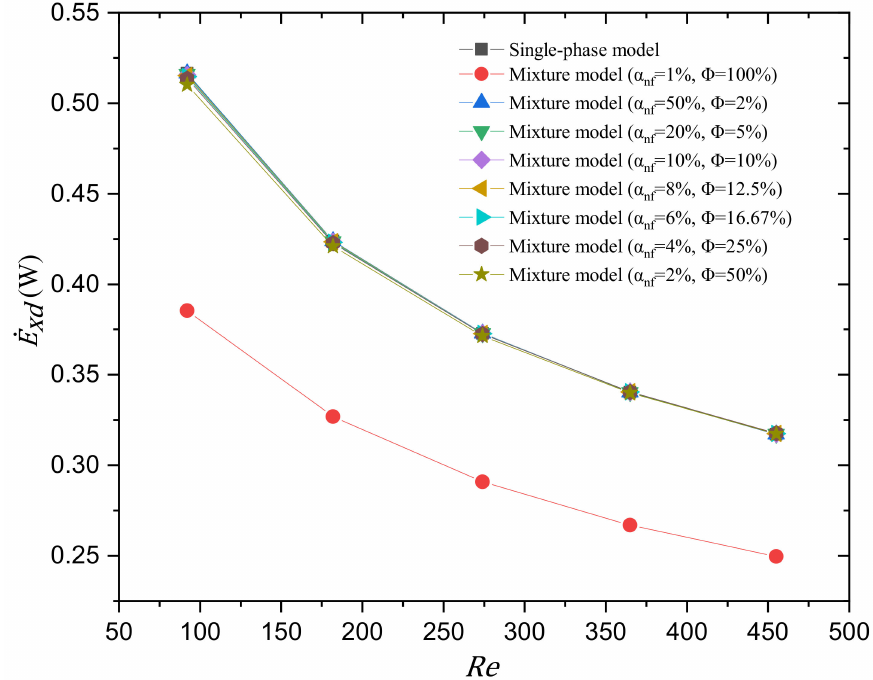
. E xd in the minchannel with Reynolds number,